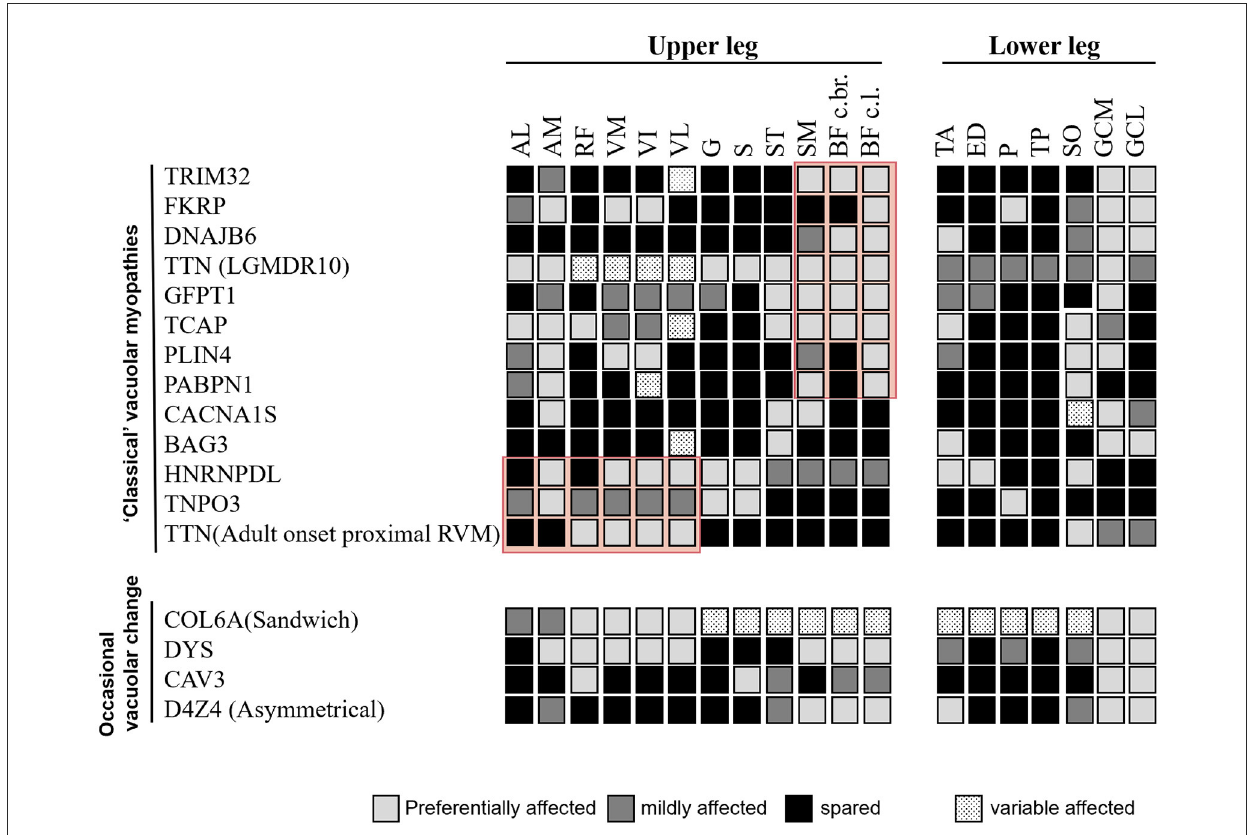
FIGURE4 Comparison of the literature-based pattern between rimmed vacuolar myopathies with proximal weakness in different disease